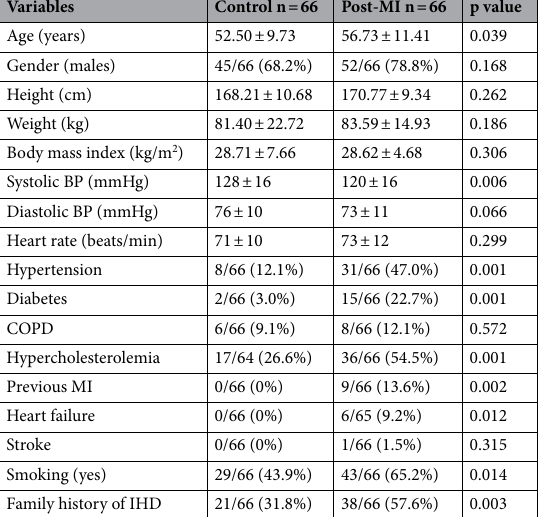
Comparison of microvascular parameters and biomarkers. Results of the comparison for microvas-